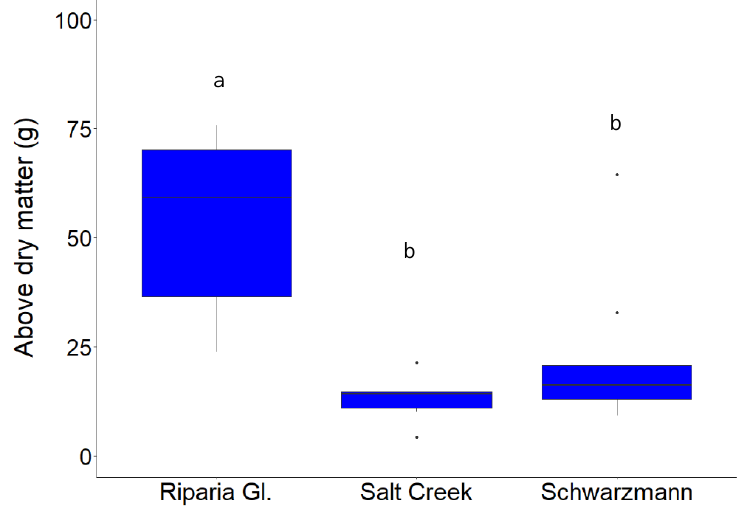
Figure A1. Total number of leaves on rootstocks inoculated with AM fungi and grown in the greenhouse. Letters above treatments represent significant differences at p < 0.05.